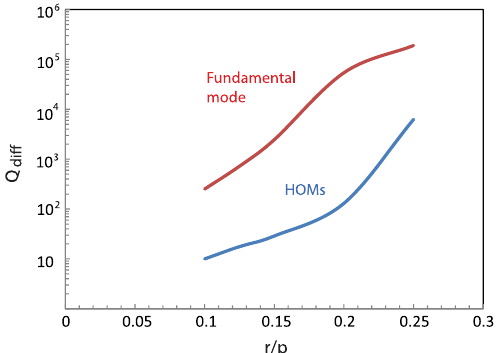
FIG. 5. Dependence of the peak surface magnetic field on the major half-axis of the elliptical rod.